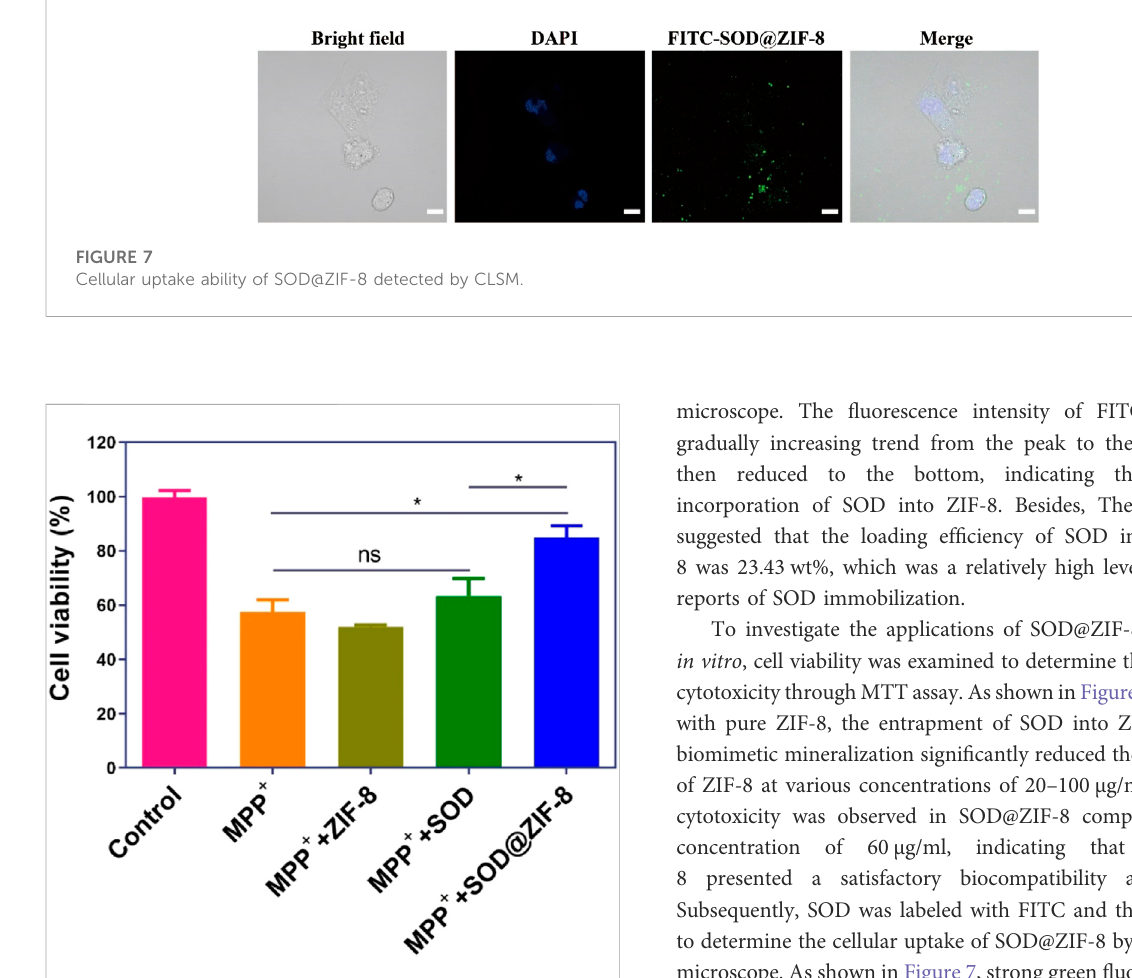
FIGURE 8 Viability of SHSY-5Y cells exposed to MPP + after different treatments.